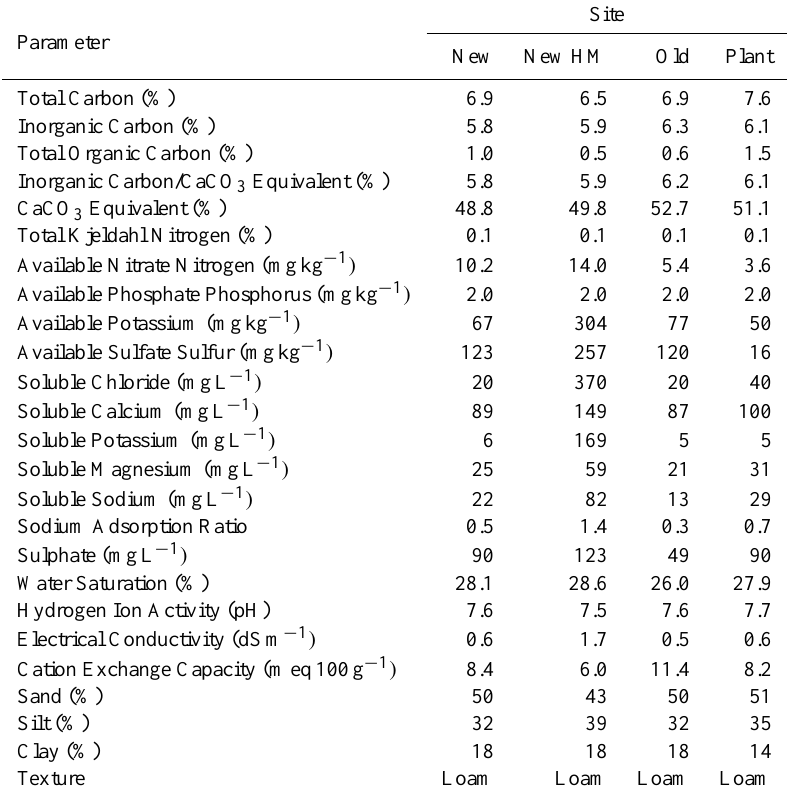
Table 1. Chemical and physical properties of the soil at Exshaw quarry research sites in August 2007 prior to application of treatments.